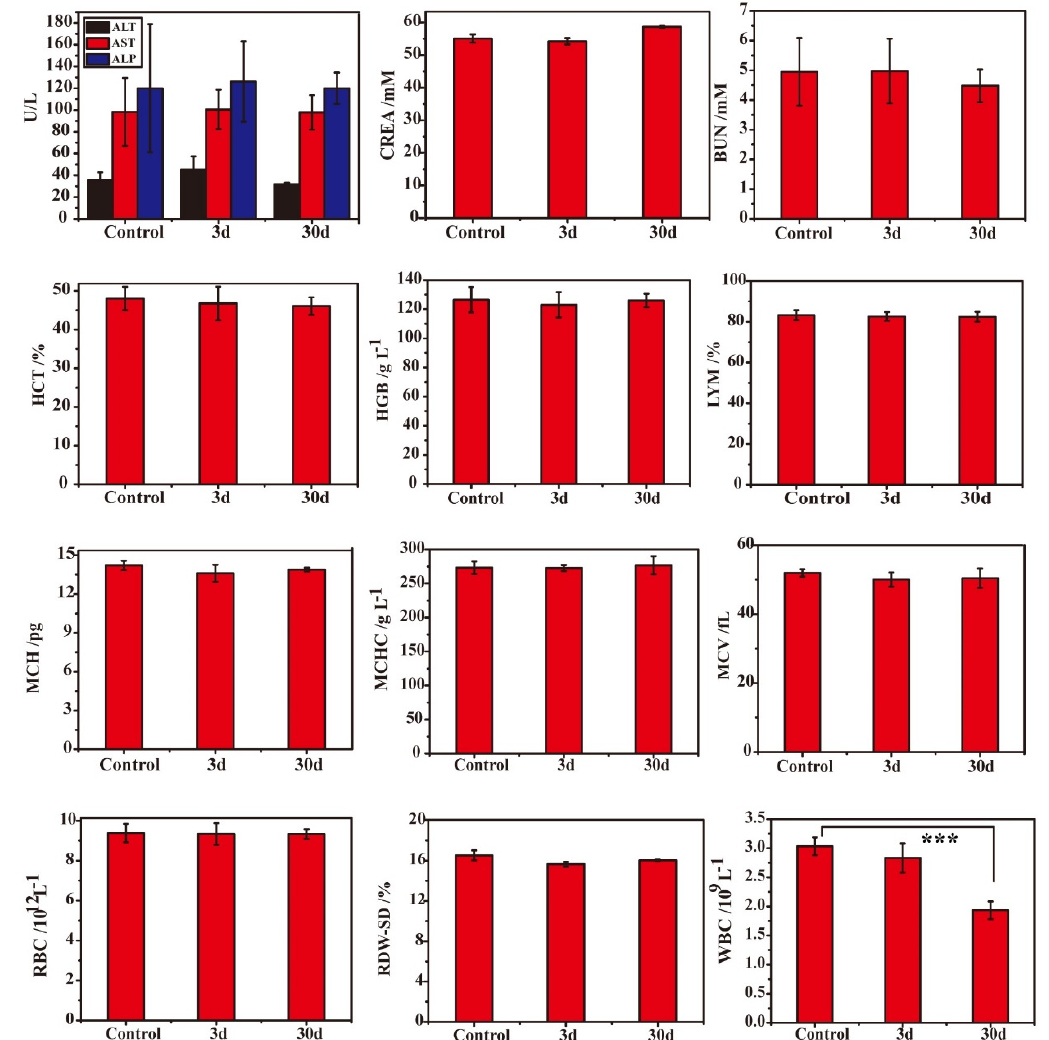
Figure 5. Blood biochemical analysis of Kunming mice after i.v. injection of DMON@GOx/3-MA with a calculated dose of 75 mg/kg at day 3 and day 30. The liver function related alanine aminotransferase (ALT), aspartate aminotransferase (AST), alkaline phosphatase (ALP), and creatinine (CREA), nephric blood urea nitrogen (BUN) and other indices show no significant change after treatment. n = 6, data are the means ± s.d. *** p < 0.001, p value was analysed by one-way ANOVA.